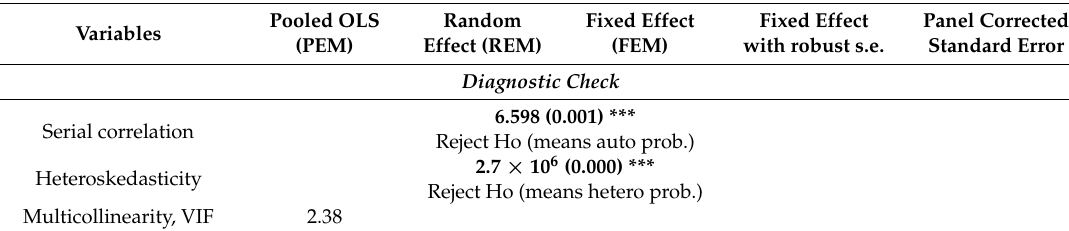
Figure 4. Interaction Effect (Gender Diversity × Foreign Participation Ratio).